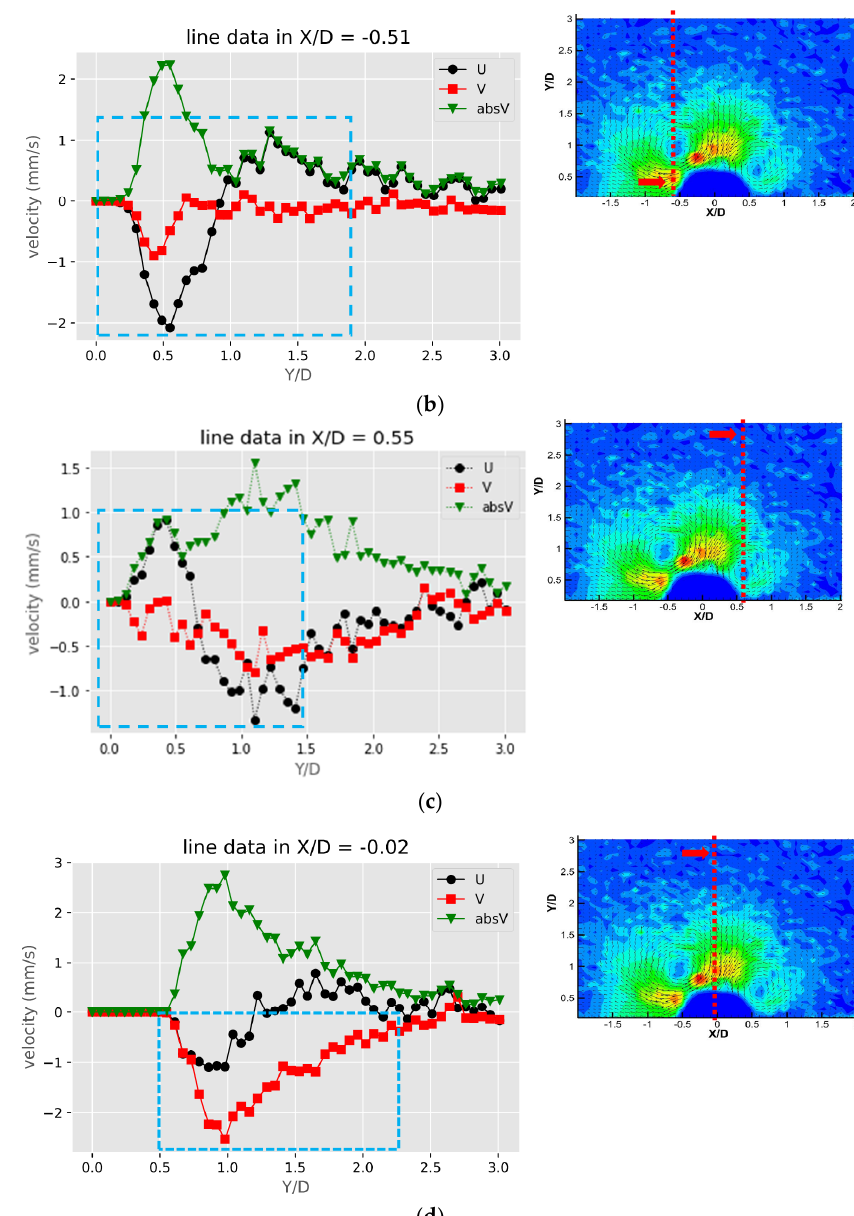
Figure 6. The profiles of velocity components in the X and Y directions (U, V) and absolute velocity (absV) of the solid bulges: ( a ) Y/D = 0.61; ( b ) X/D = −0.51; ( c ) X/D = 0.55 and ( d ) X/D = −0.02.